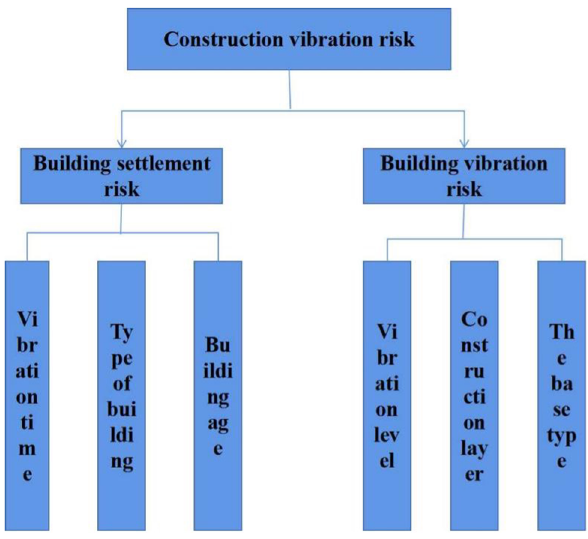
Figure 1: Index system of construction vibration risk assessment